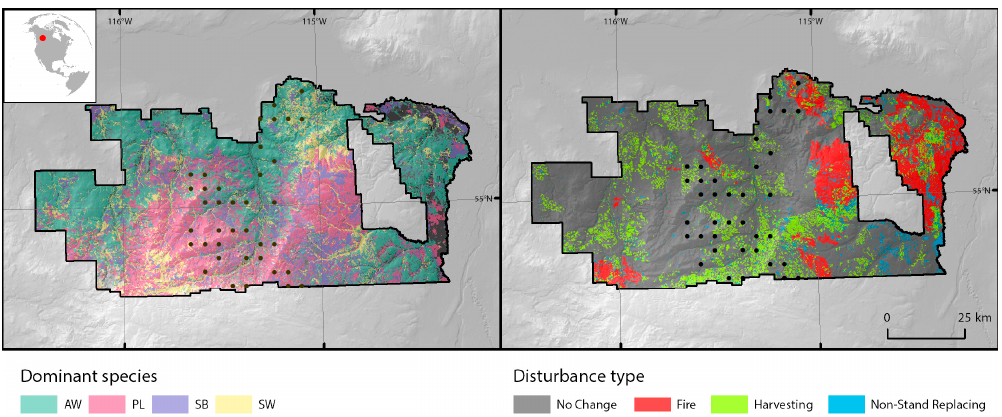
Figure 1. Location and outline of the study area. Black dots indicate sample plot locations. Dominant species codes: AW: Trembling aspen; PL: Lodgepole pine; SB: Black spruce; SW: White spruce.